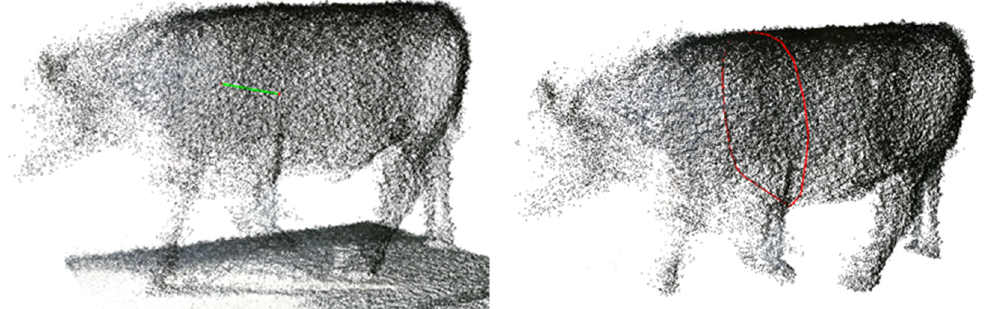
Figure 3. Measurement of withers height and hip height on a 3-D animal model.